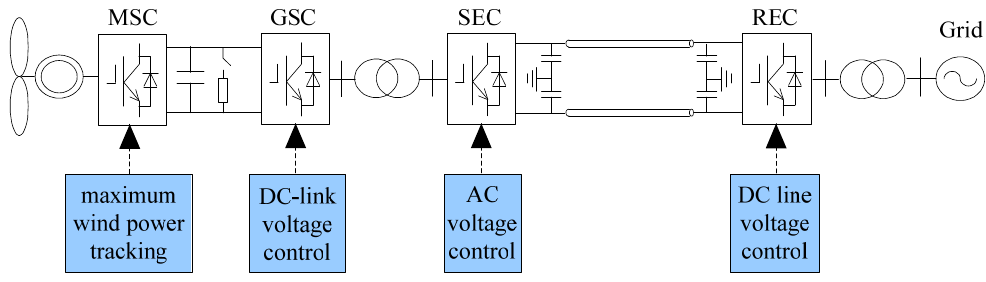
Figure 3. The control mode of a VSC-HVDC-based wind power system under normal